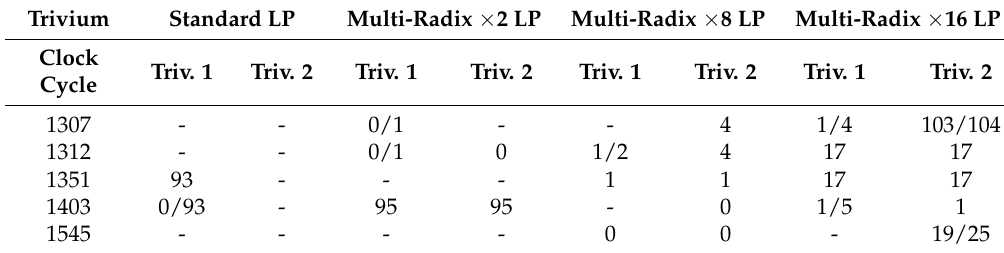
Table 8. Position of the faults injected into each pair of low-power Trivium cipher versions in different clock